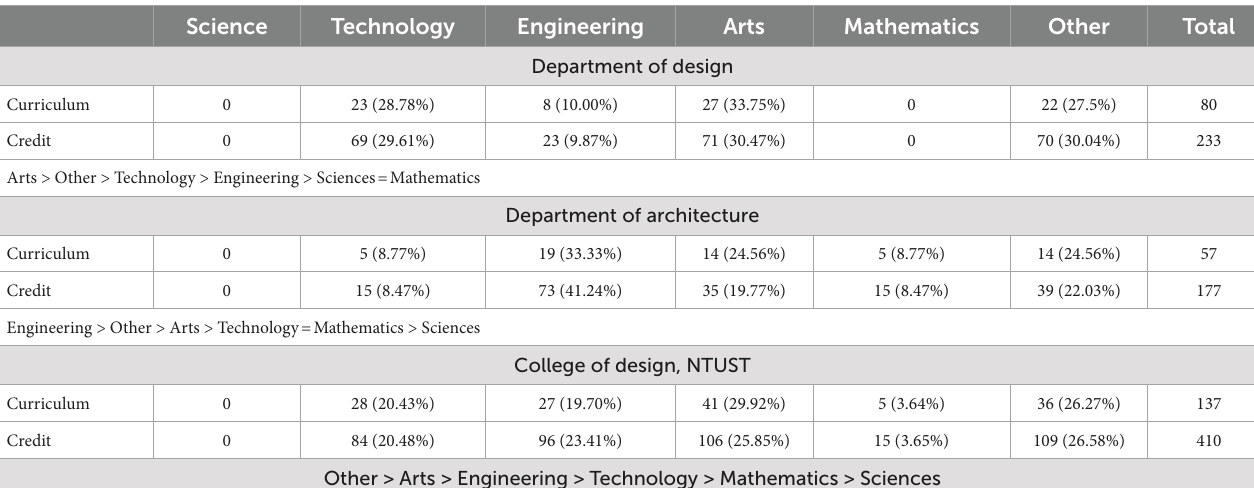
TABLE 11 The curriculum of the college of design,